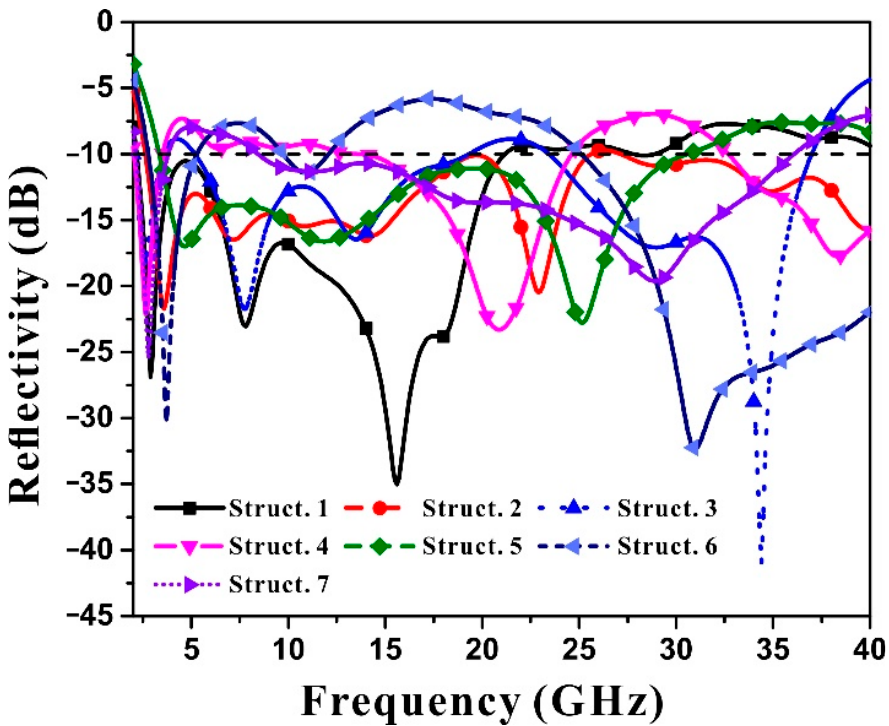
Figure 4. Simulated reflectivity of seven configurations at 2–40 GHz based on the measured electro- magnetic parameters of carbonyl iron/carbon nanotube hybrid